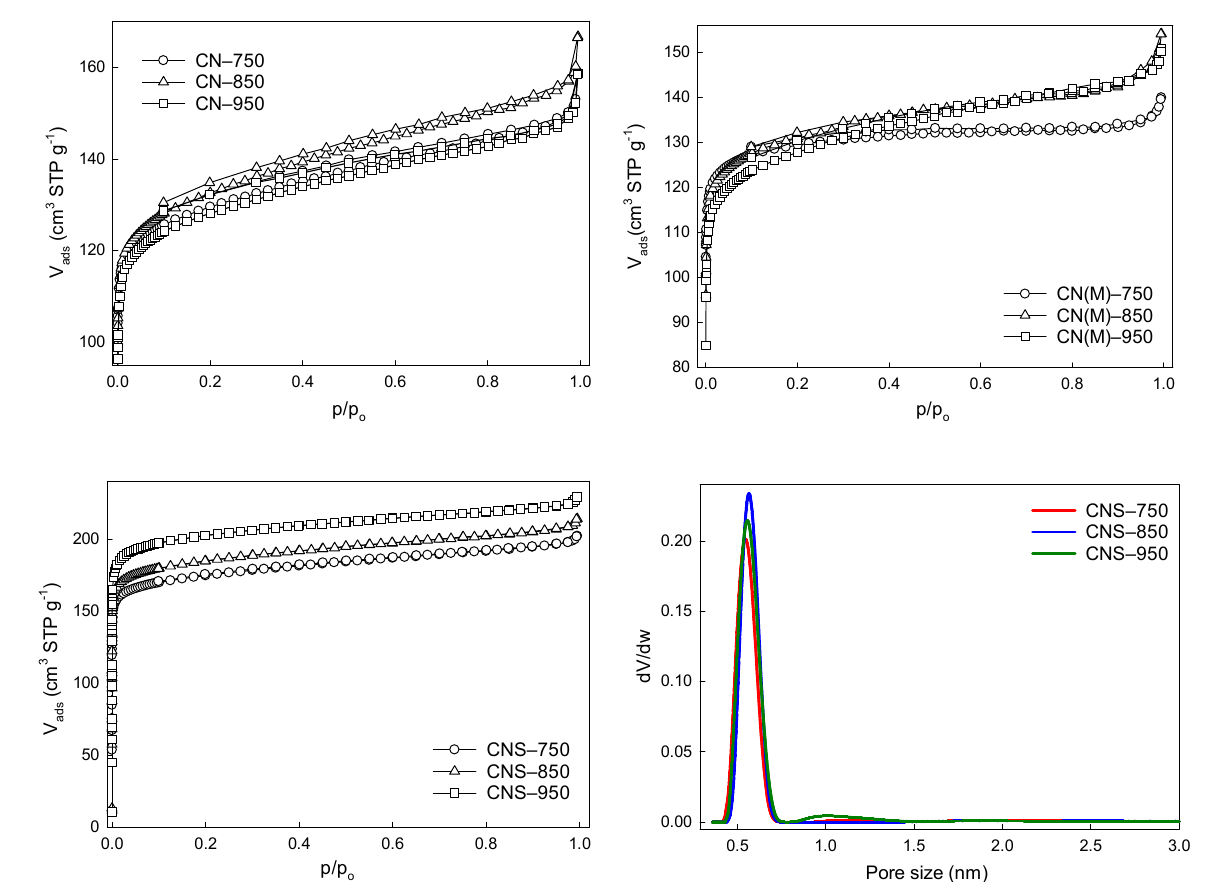
Figure 8. N 2 adsorption–desorption isotherms of CN, CN(M) and CNS carbon gels obtained from a phloroglucinol:aldehyde molar ratio of 1:3 and pyrolyzed at three different temperatures. Pore size distribution (PSD) plots are also presented for the CNS carbon samples.